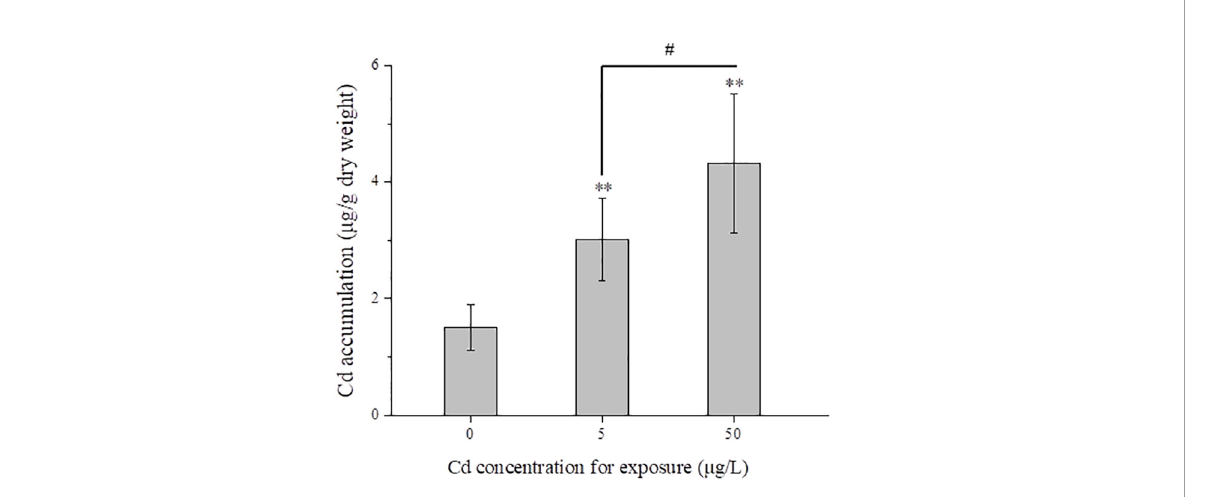
FIGURE 1 Mean total Cd concentrations ( m g/g dry weight) in liver tissues ( n = 5) from control and Cd treatments after exposure for 14 days. # represents 7 P < 0.05, and ** represents P <